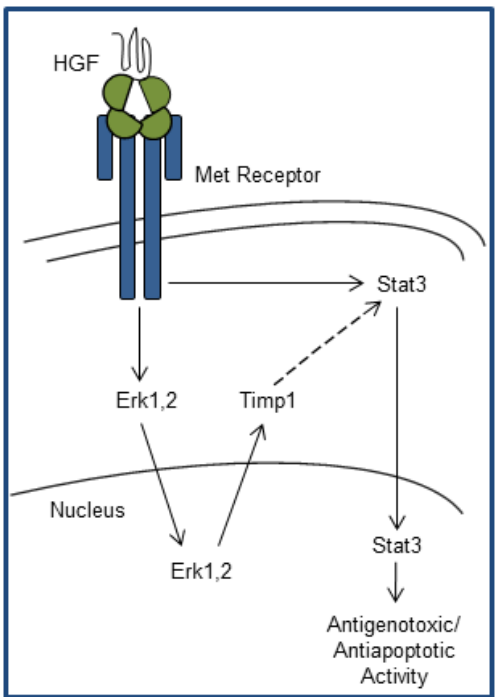
Figure 5. Model of the cardioprotective action against anthracycline damage mediated by Met-Erk1,2-Timp1-Stat3 signaling in cardiac cells. HGF treatment stimulates the Met receptor that quickly leads to phosphorylation and nuclear translocation of Erk1,2. In the nucleus, Erk1,2 induces gene transcription of Timp1, the inhibitor of metalloproteases, which allows an endurable Met-dependent activation of Stat3. Thus, Met belatedly stimulates Stat3 and exerts cardioprotective functions. Black arrow lines indicate phosphorylation / activation. Dotted arrow line indicates activation within the cascade.